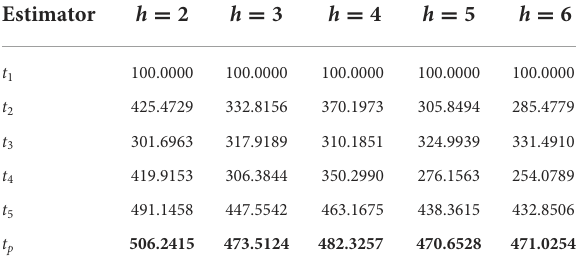
TABLE 6 PRE of different estimators with respect to t 1 for Population 5.